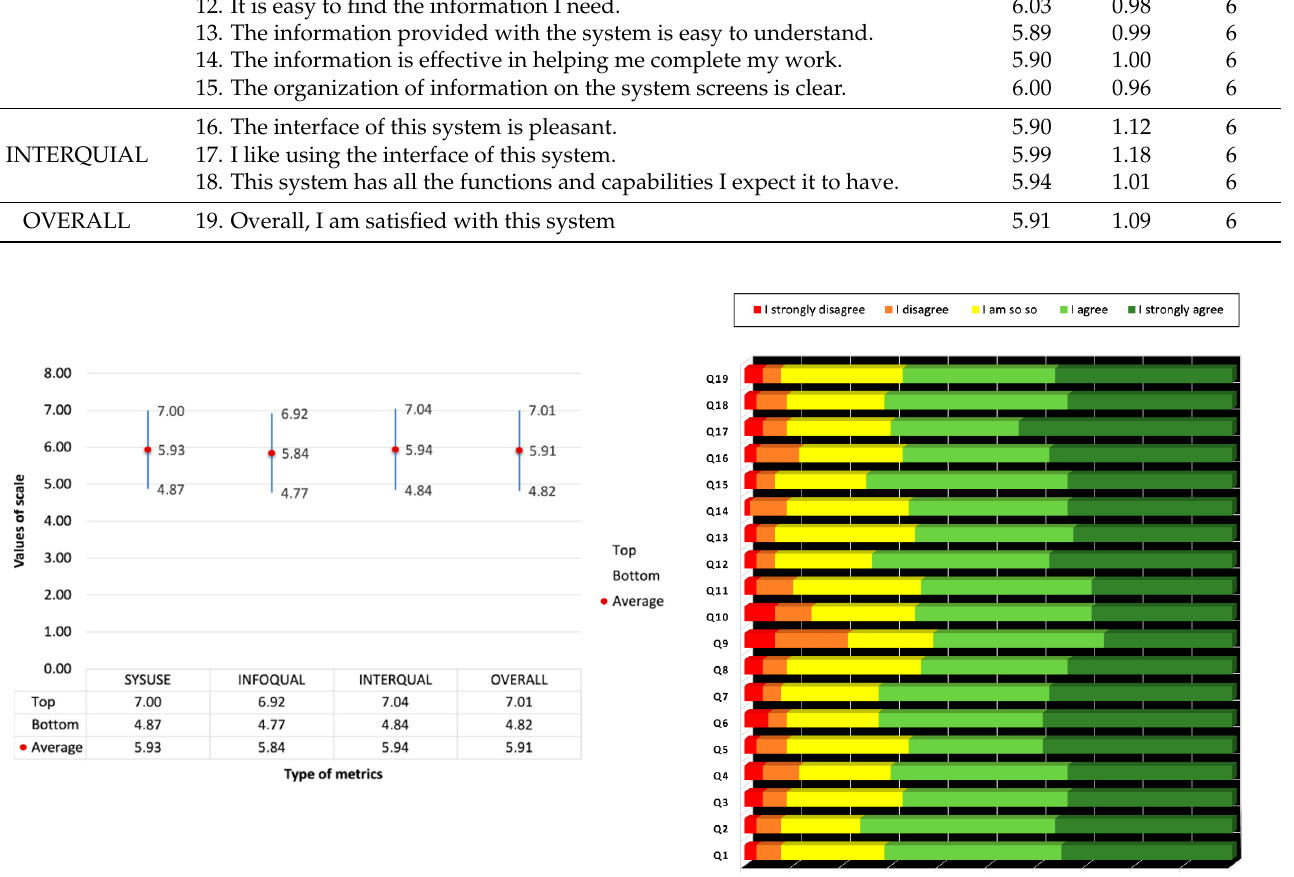
Figure 5. ( Left panel ): IBM CSUQ question graph. ( Right panel ): IBM CSUQ metrics.